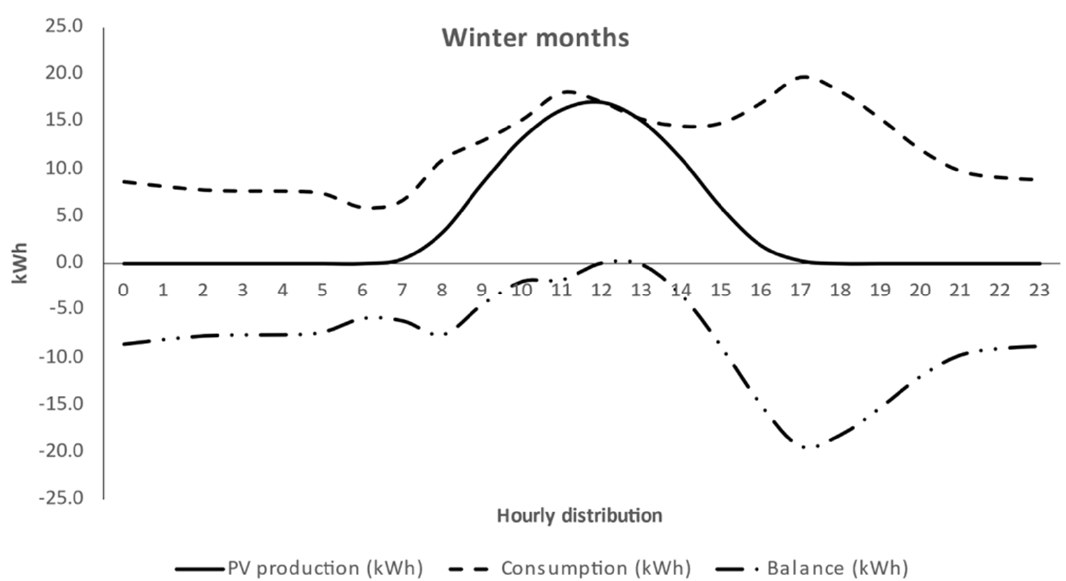
Figure 8. Average daily distribution of production, consumption, and balance for the winter months (November to February).